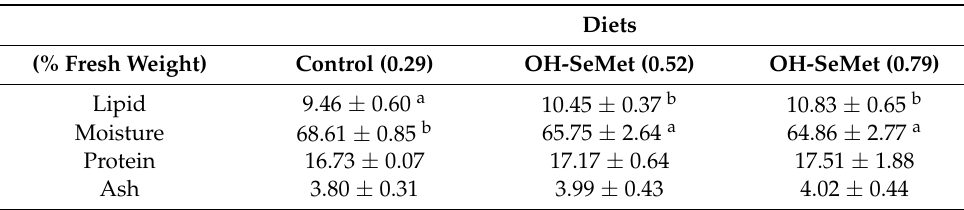
Table 6. Whole-body proximate composition (% fresh weight) of seabream after 13 weeks of feeding diets with different supplementation of OH-SeMet.